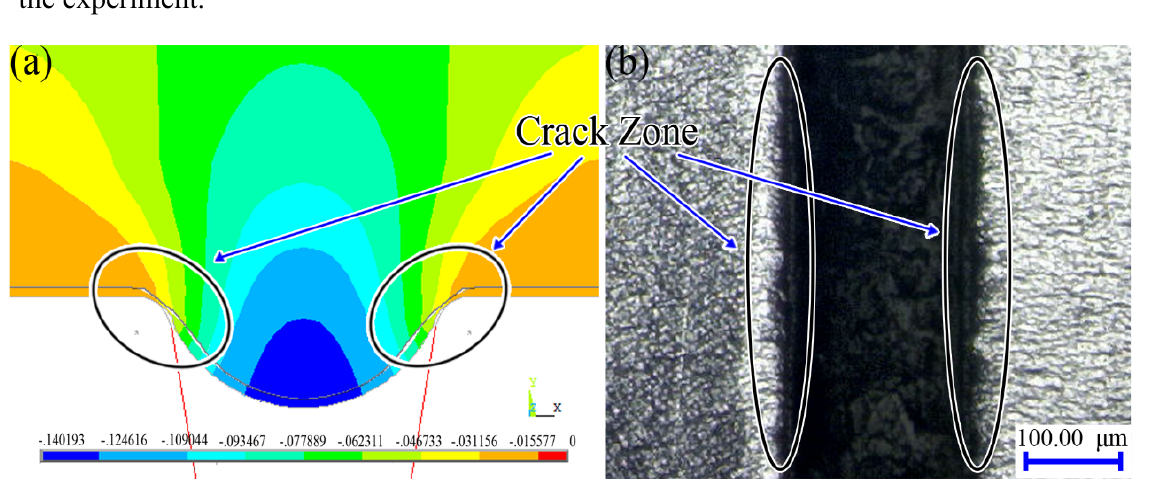
Figure 13. Comparison of the micro-crater pro file s between the experimental and the numerical